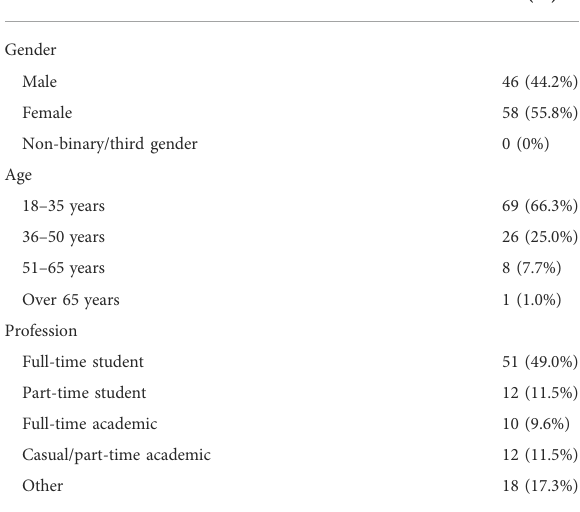
TABLE 2 Summary of the sample ’ s demographic characteristics.